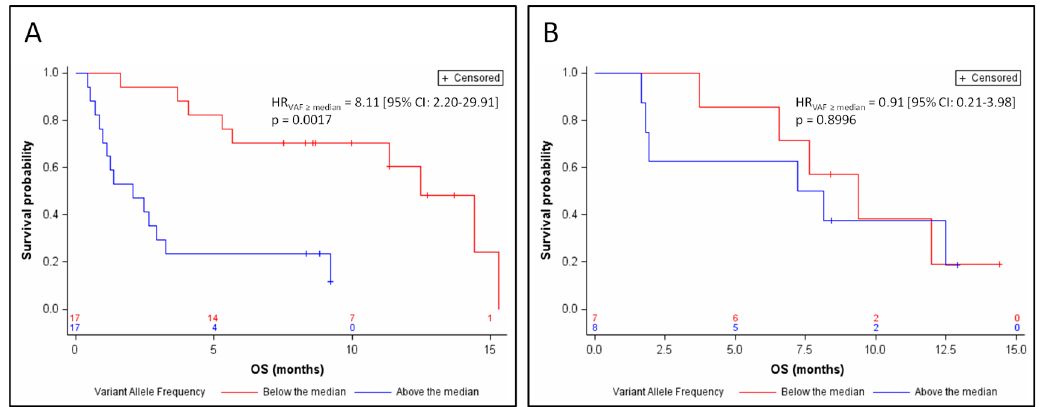
Figure 4. Kaplan–Meier estimates of overall survival, depending on relative ctDNA abundance (above or below the median) for patients treated with atezolizumab ( A ) or chemotherapy ( B ).